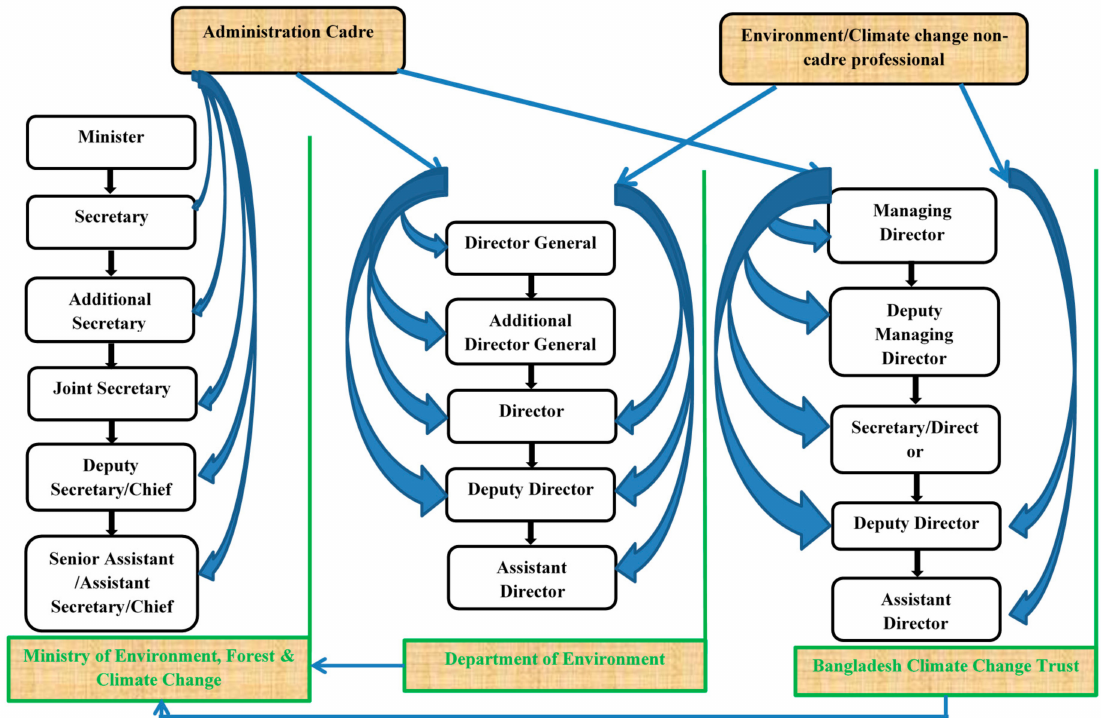
Figure 7. Hierarchical (horizontal and vertical) administrative positions of administration cadre bureaus with big influence in climate related decision-making